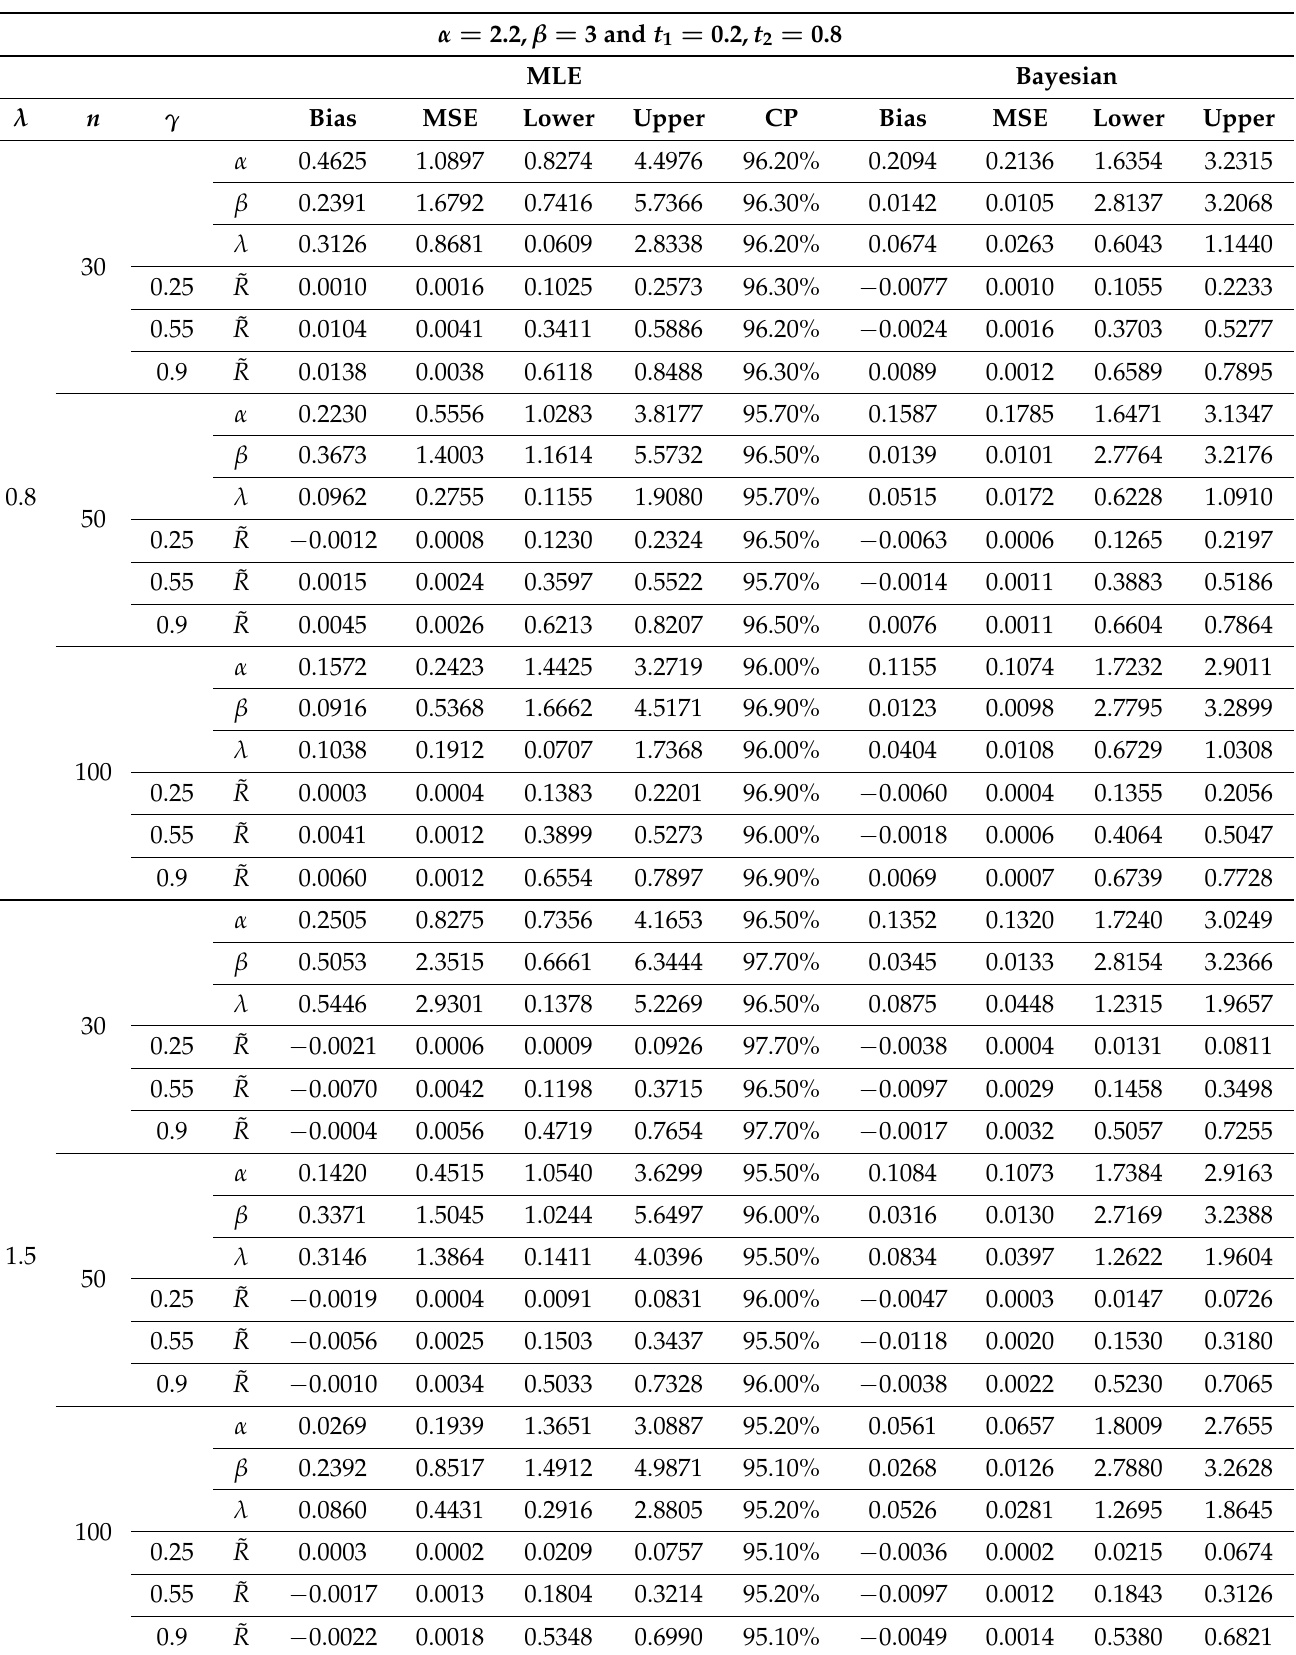
Table 3. Bias, MSE, and CI for fuzzy reliability and parameters of models in case